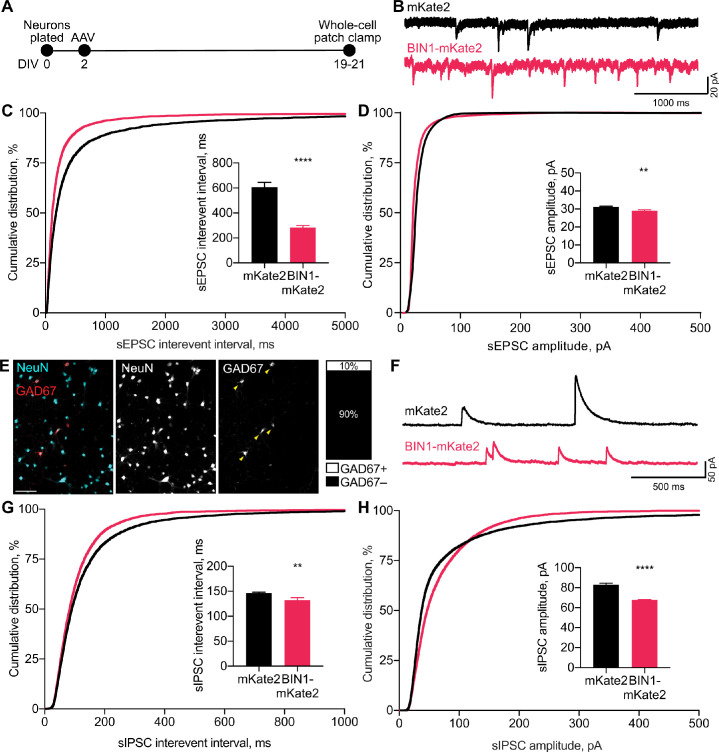
BIN1 increases both excitatory and inhibitory synaptic transmission.(A) Synaptic transmission recordings experimental timeline: neurons were plated on DIV 0, virally transduced on DIV 2, electrophysiologically recorded on DIV 19–21. (B) Representative traces of sEPSCs recorded from neurons transduced with mKate2 or BIN1. (C) BIN1 decreased mean sEPSC interevent interval (Kolmogorov-Smirnov test on cumulative distribution, ****p<0.0001, KS D score: 0.1657; unpaired two-tailed Student’s t-test on mean IEI, ****p<0.0001). (D) BIN1 slightly decreased mean sEPSC amplitude unpaired (Kolmogorov-Smirnov test on cumulative distribution, ****p<0.0001, KS D score: 0.1803; unpaired two-tailed Student’s t-test on mean amplitude, ***p=0.0004) (n = 12–21 neurons per group from three different primary neuron harvests). (E) Representative images and quantification of NeuN and GAD67+ neurons in primary hippocampal cultures at DIV 12 (n = 255 GAD67+ neurons, n = 2342 NeuN+ neurons, from 10 randomly taken images per coverslip, 10 coverslips from two different primary neuron harvests.) Scale bar = 100 µm. (F) Representative traces of sIPSCs recorded from neurons transduced with mKate2 or BIN1. (G) BIN1 decreased mean sIPSC interevent interval (Kolmogorov-Smirnov test on cumulative distribution, ****p<0.0001, KS D score: 0.06862; unpaired two-tailed Student’s t-test on mean IEI, **p=0.0035) (H) BIN1 decreased mean sIPSC amplitude (Kolmogorov-Smirnov test on cumulative distribution, ****p<0.0001, KS D score: 0.1297; unpaired two-tailed Student’s t-test on mean amplitude, ****p<0.0001) (n = 11–16 neurons per group from three different primary neuron harvests). All data are expressed as mean ± SEM.